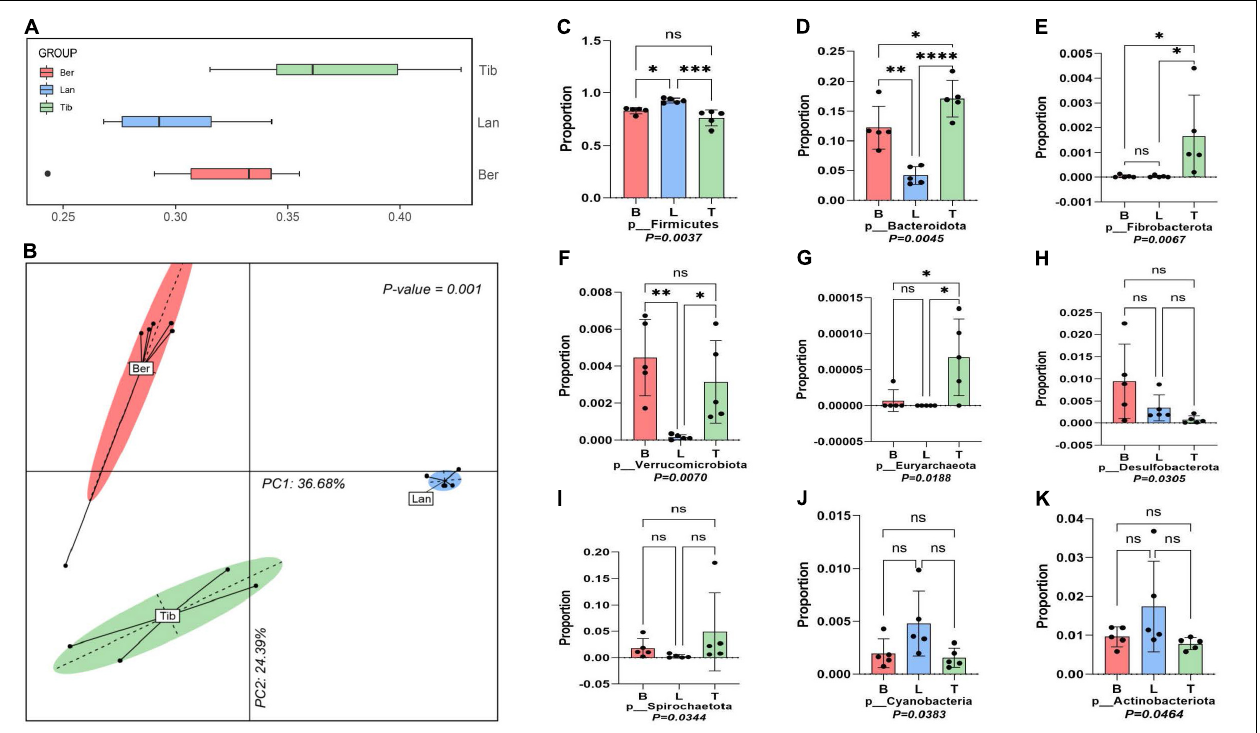
FIGURE 2 | Boxplot, principal coordinate analysis (PCoA), and dominant phylum analysis. Boxplot (A) and Principal coordinate analysis (PCoA) based on weighted UniFrac Distances per pig fecal sample (B) . Dominant bacteria phyla of three different breeds of pigs were screened out by the Kruskal–Wallis test (C–K) . ns was considered insignificant; ∗ p < 0.05 was considered as significant difference; ∗∗ p < 0.01, ∗∗∗ p < 0.001 and ∗∗∗∗ p < 0.0001 was taken as very significant